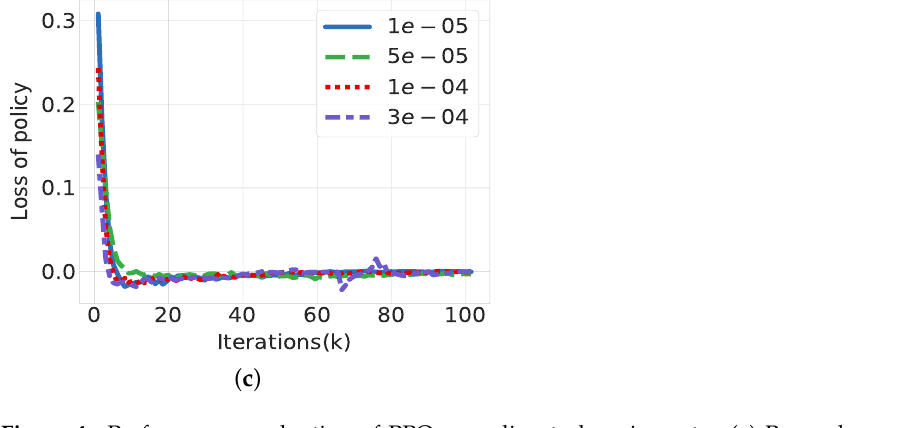
Figure 4. Performance evaluation of PPO according to learning rate. ( a ) Reward convergence. ( b ) Value loss. ( c ) Policy loss.